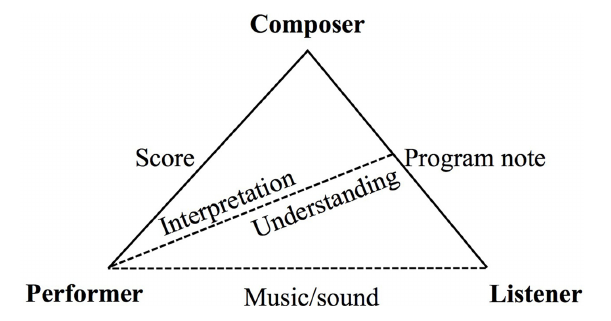
FIGURE 1 | Initial model of communication from composer through to program note and